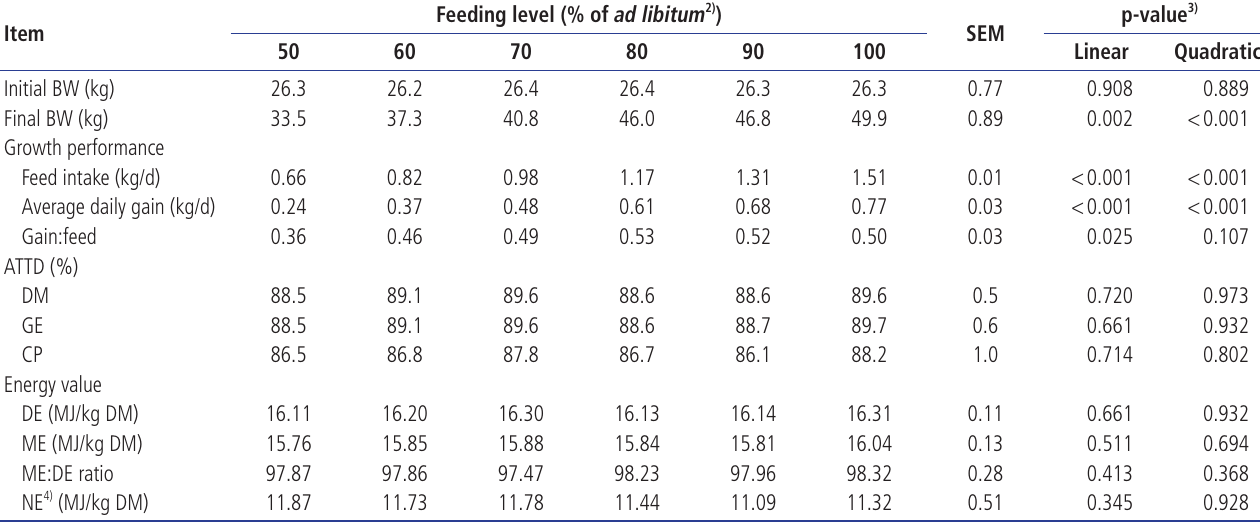
Table 2. Effects of feeding level on growth performance, apparent total tract digestibility of nutrients and energy and energy values of diets in growing pigs